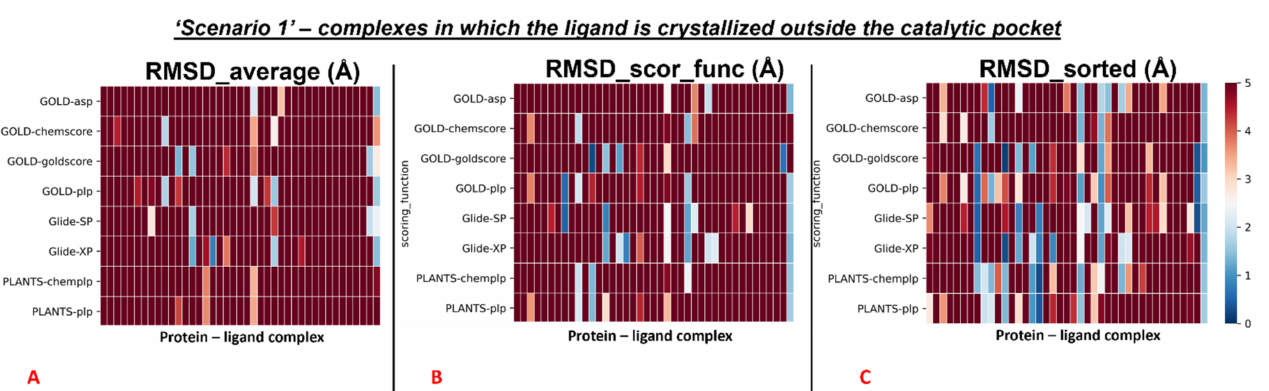
Figure 4. Colormaps represent the results of the self-docking experiments just for the ligands crystallized inside the orthosteric pocket in the situation in which the crystallographic water molecules are not considered during the docking runs. ( A ) Results coming from the average of the RMSDs of all the poses for each docking run. ( B ) Results derived just from the RMSD between the crystallographic ligand coordinates and the pose classified as the best from the scoring function. ( C ) Results of the self-docking experiments if just the pose showing the best RMSD value between its coordinates and the crystallographic ones is retained. The x -axis lists all the different protein–ligand complexes, which are plotted against the different pairs docking program-scoring function used for this study, reported in the y -axis.